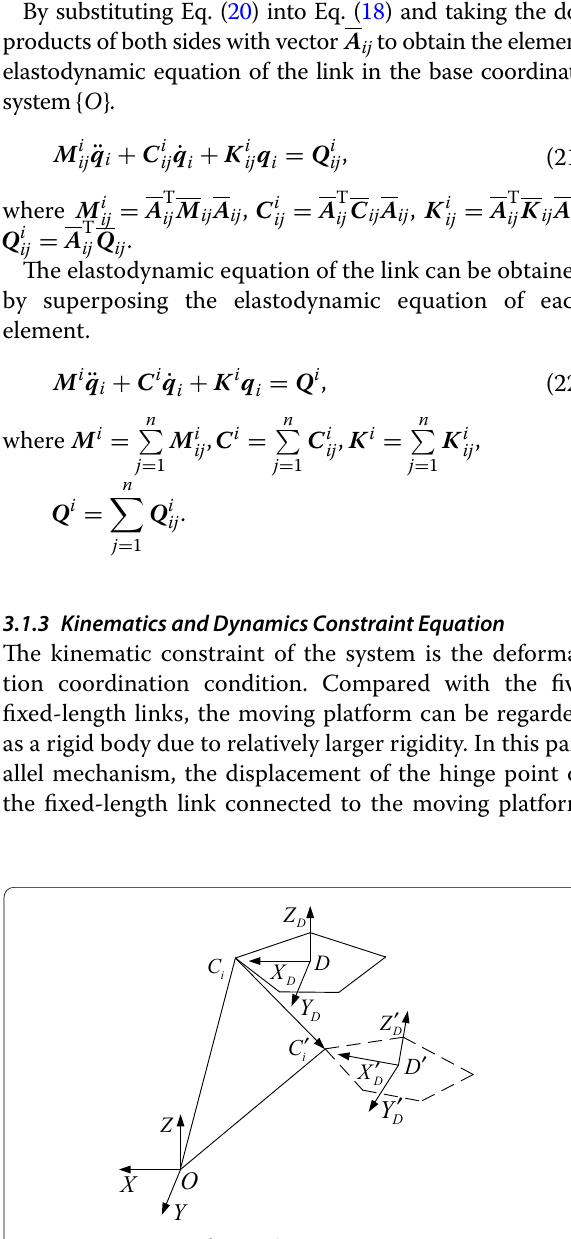
Figure 9 Constraints of system